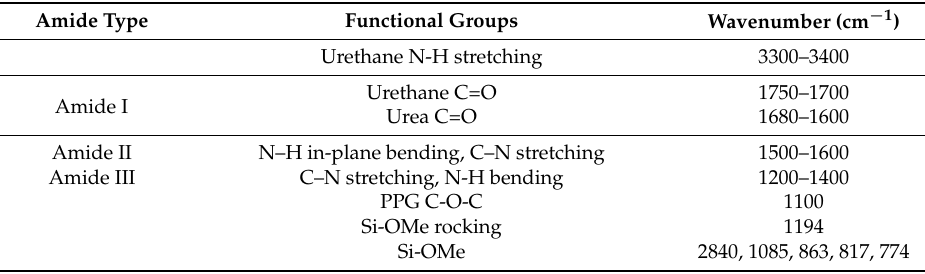
Figure 5. The comparison of ATR-FTIR spectra of SPUR 8 taken at different reaction stages. Table 4. The assignments of functional groups of SPUR